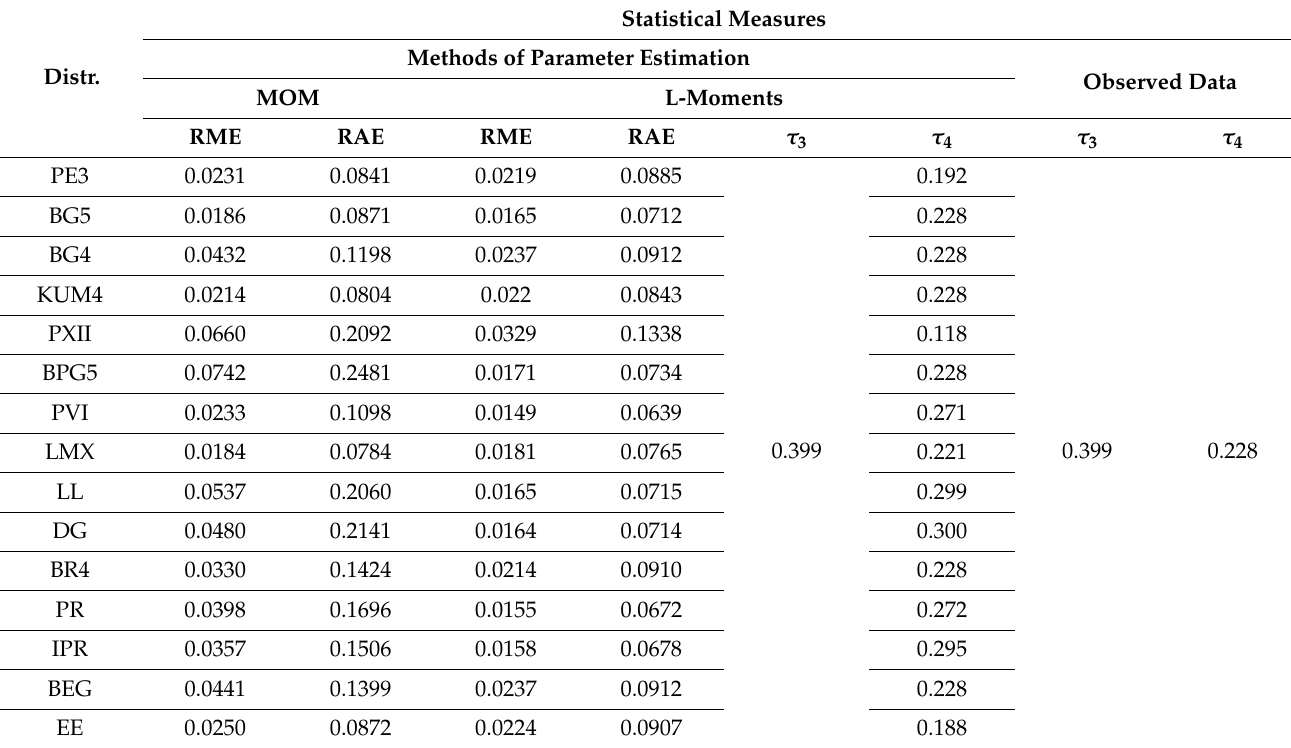
Table 8. Distributions performance